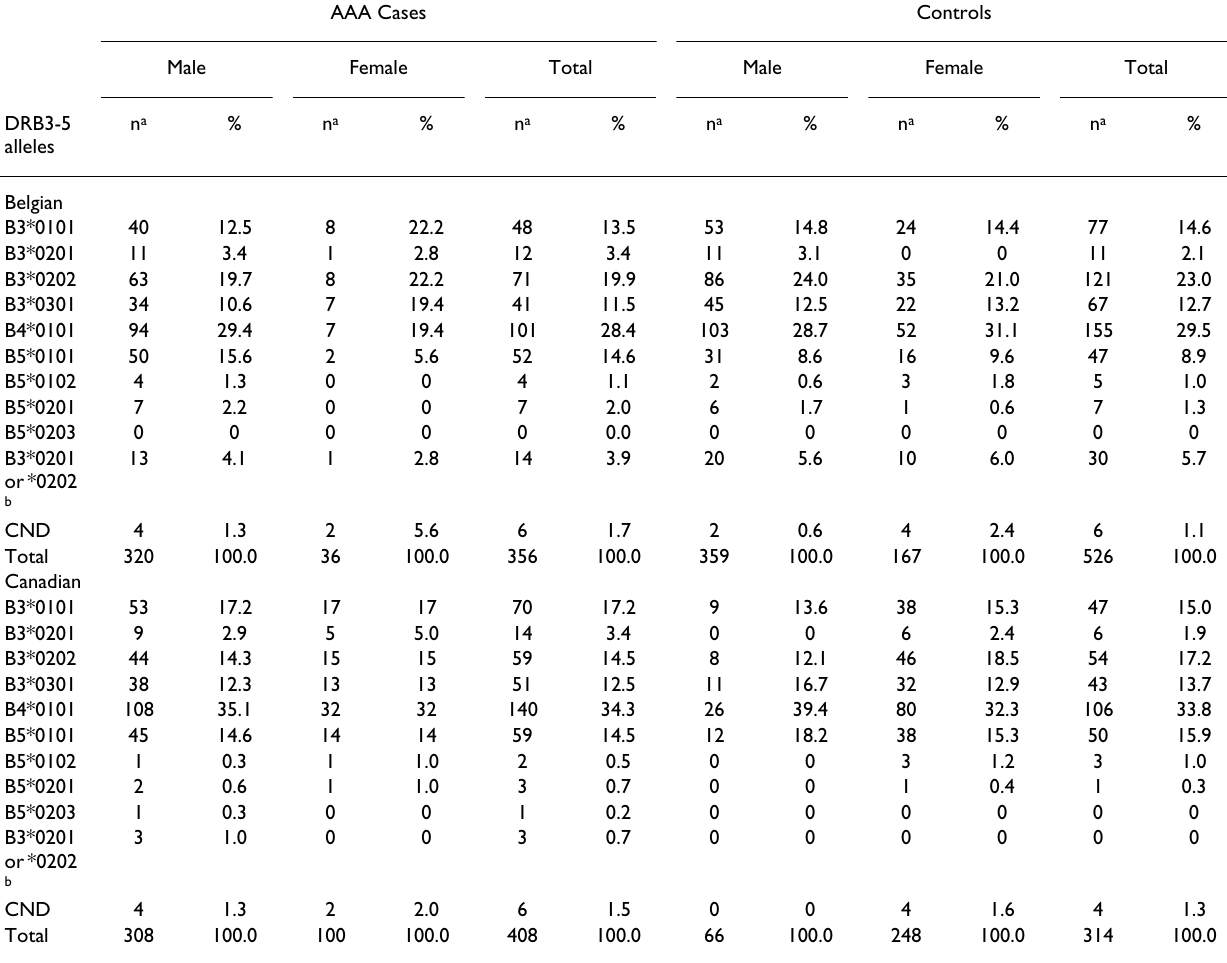
Table 4: HLA-DRB3-5 allele frequencies in AAA cases and controls AAA